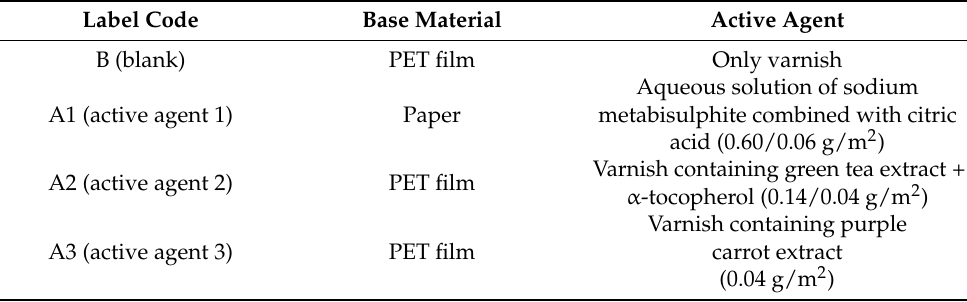
Table 1. Composition of the active labels used in study.